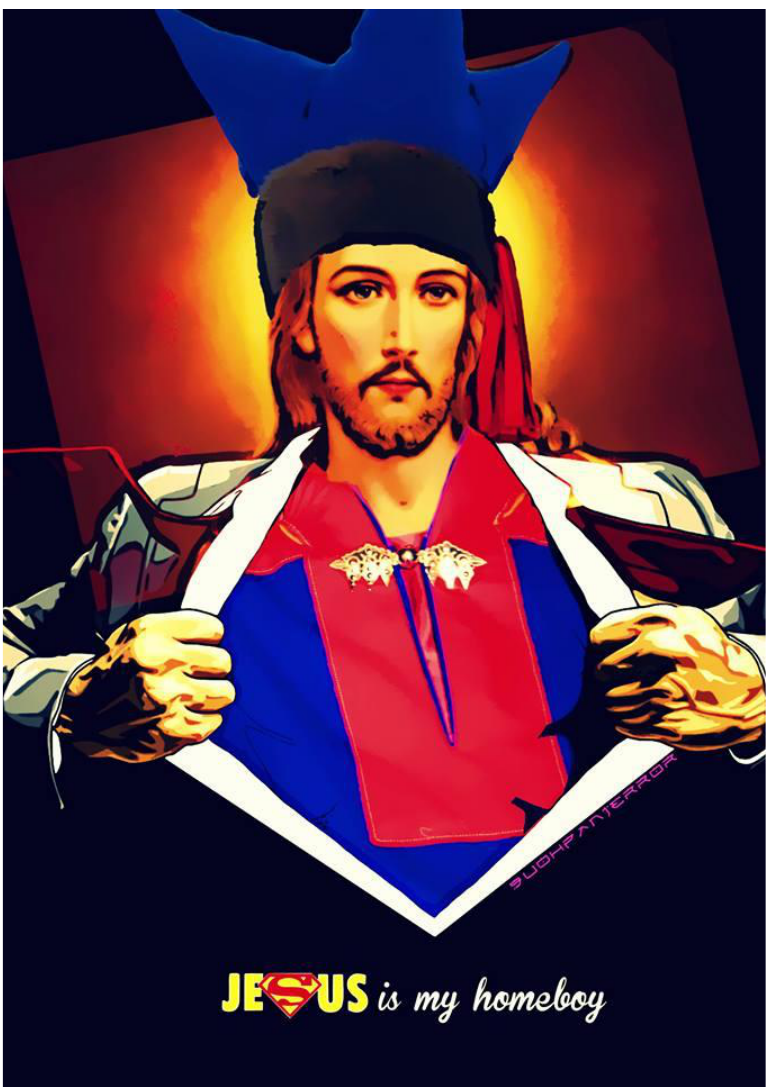
Figure 7. A Suohpanterror poster. 32